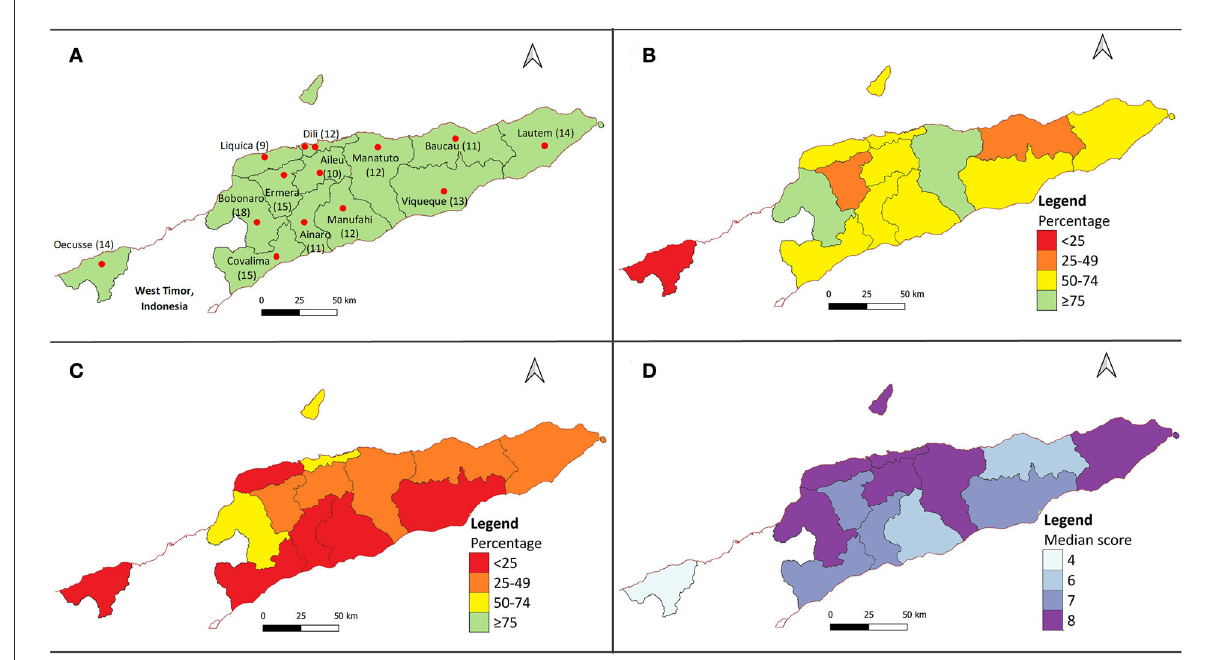
FIGURE2 Map of Timor-Leste showing (A) all 13 municipalities where numbers shown after the name of each municipality refer to the number of government animal health workers interviewed in each location. The red circles represent the locations where interviews were conducted in each municipality. (B) Percentage of participants who had knowledge of how antibiotics worked. (C) Percentage of participants who had knowledge of antibiotic resistance. (D) Median attitude